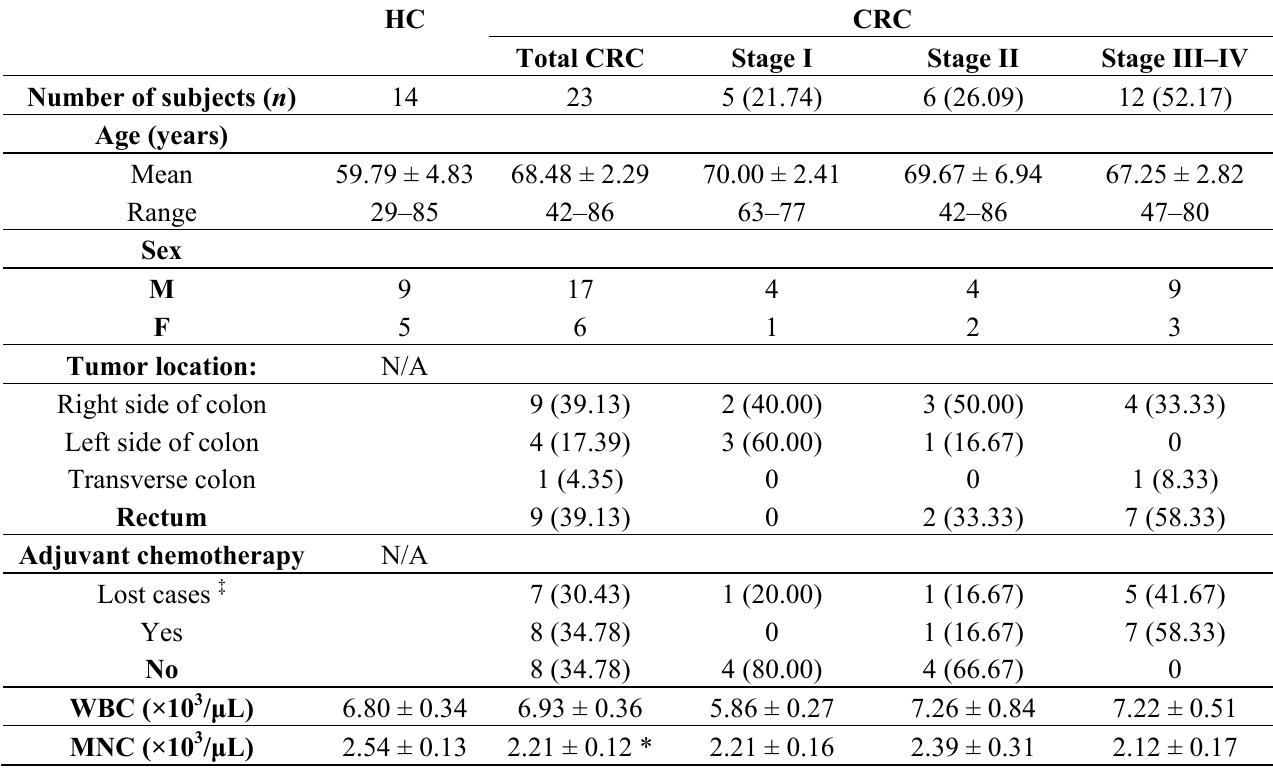
Table 1. Baseline characteristics of CRC patients and healthy